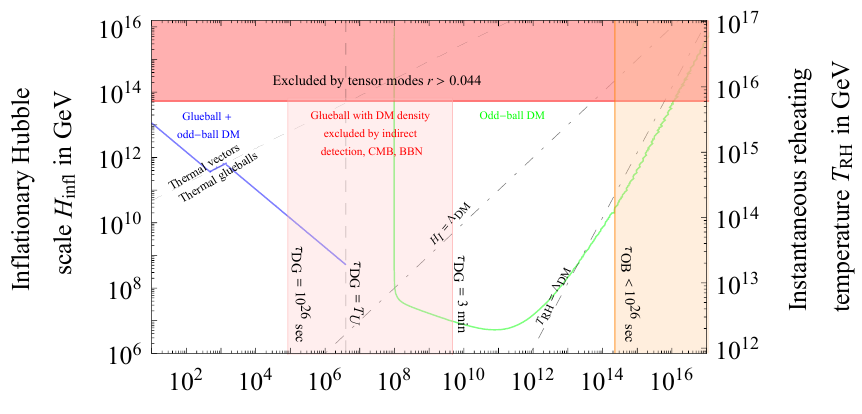
Figure 3 . Parameter space of the SO(10) model. The DM abundance is reproduced along the blue curve (in which case it is composed of both ordinary dark glueballs and odd-balls) and along the green curve (in which case it is composed of odd-balls only, since other glueballs have decayed). The upper red region is excluded from the current bound on the tensor inhomogeneities. Finally, assuming generic Planck-suppressed operators in the pink and orange regions some state decays with lifetime between 3 min and 10 26 sec : these regions are excluded by indirect detection, CMB and Big Bang Nucleosynthesis constraints if the decaying state has a relic abundance comparable to